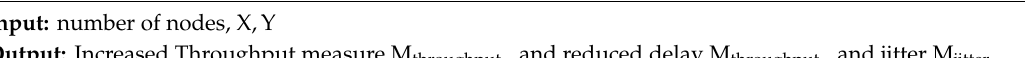
Algorithm 1: Algorithm for the proposed agent